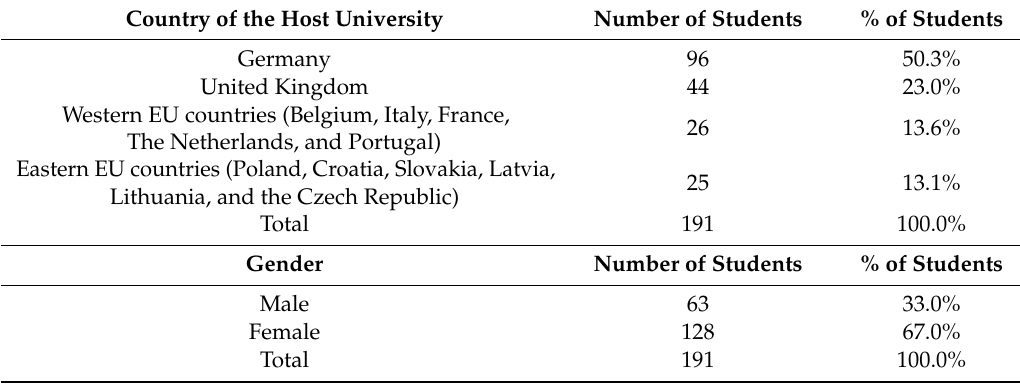
Table 2. Respondent